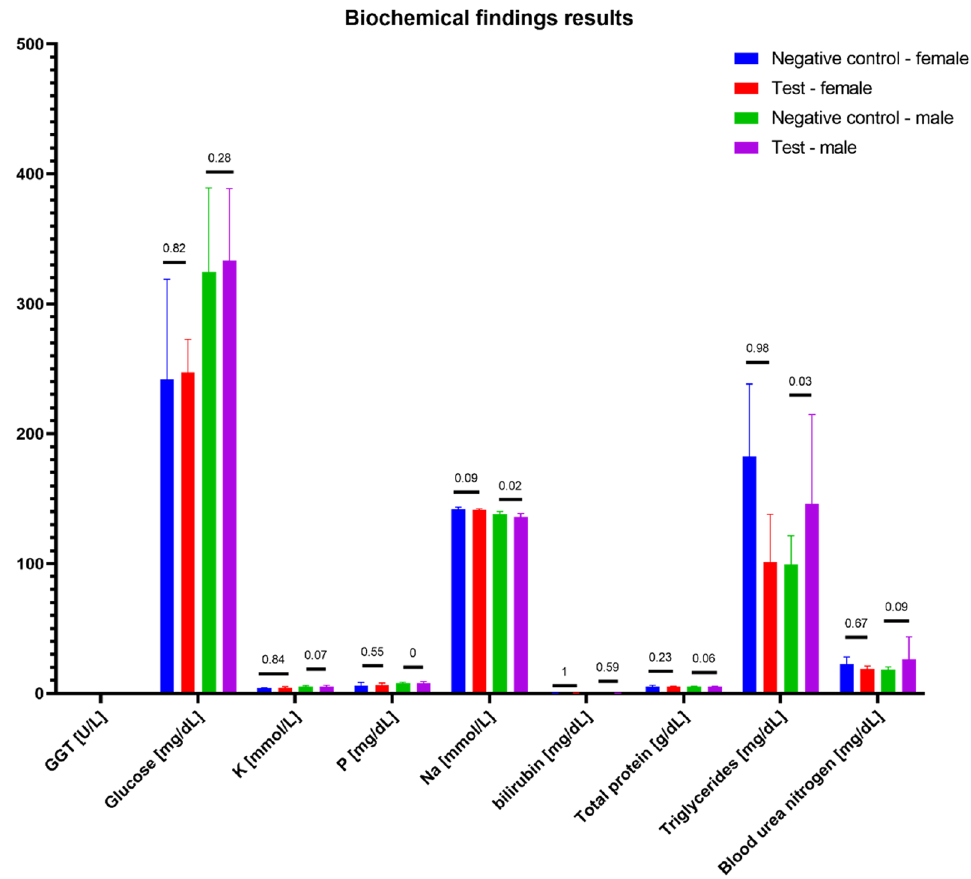
Figure 8. Biochemical findings results. Statistically, significant differences were observed in triglycerides, Na, and P levels between the control and test group of male rats. However, the difference did not impact the clinical status of the animals. No other statistically significant differences were observed among the remaining